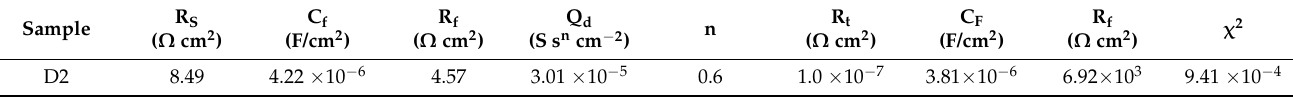
Table 3. The values of equivalent circuit for sample D2.